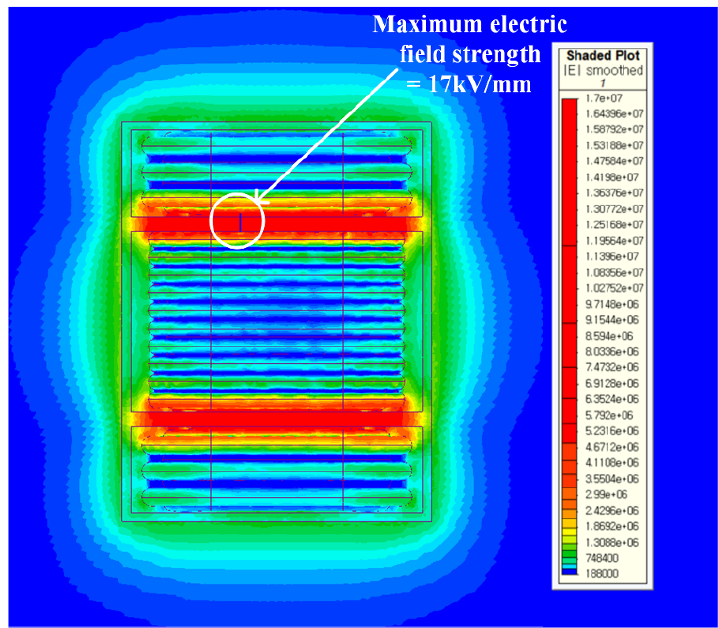
Figure 10. Electric field simulation results of section bobbin